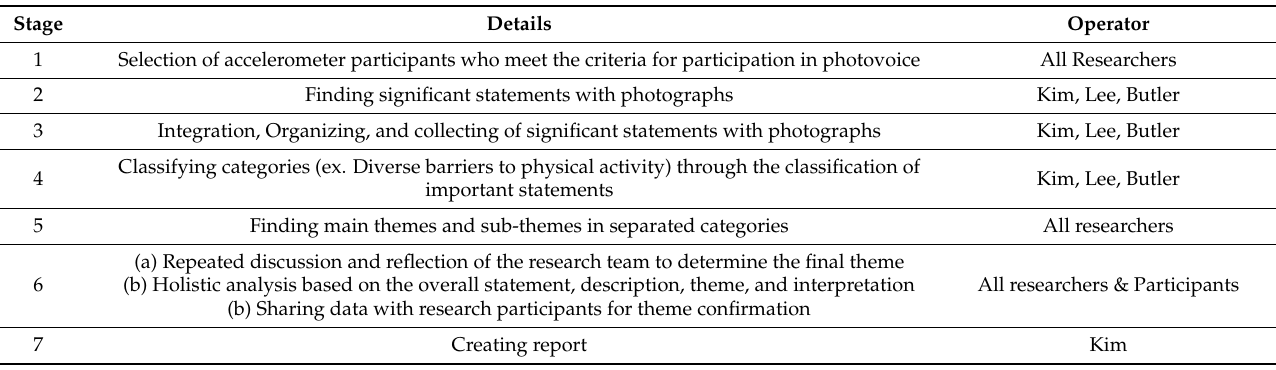
Table 3. Data analysis